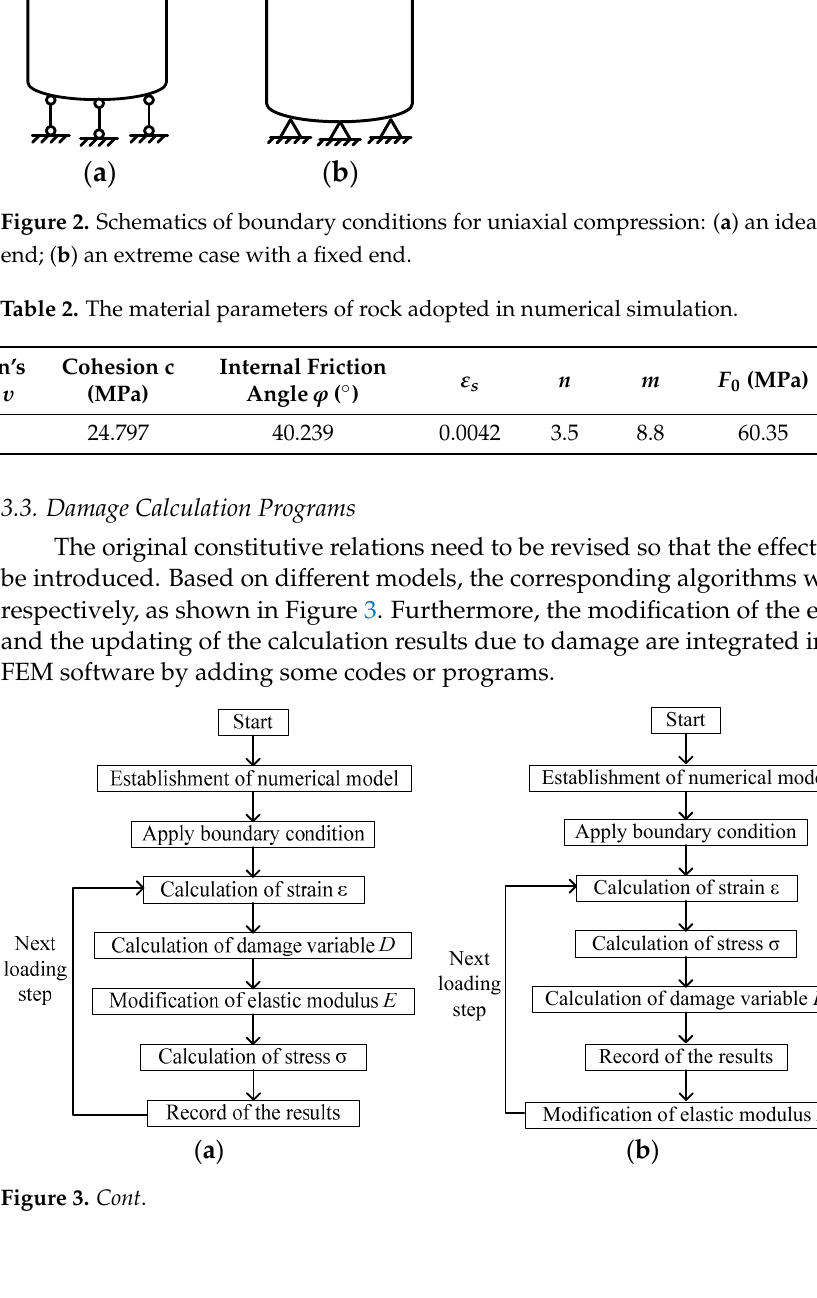
( c ) Figure 3. Calculation programs of three representative models: ( a ) the empirical damage model; ( b ) the statistical damage model; and ( c ) the elastoplastic damage model. 4. Results and Discussion 4.1. Uniform Compression Condition 4.1.1. Stress-Strain Response Stress-strain curves were often used to describe the deformation and failure process of rock specimens. In this section, the test results [47,48] were used for verification. Three models were calculated respectively under the boundary conditions in which the top and bottom surfaces were set free in the horizontal direction. The results of the stress-strain curves are illustrated in Figure 4. The horizontal axis represents the axial strain obtained by the ratio of the given axial displacement to the model height. The vertical axis repre- sents the axial stress obtained by the ratio of the stress integral on the top surface to its area.